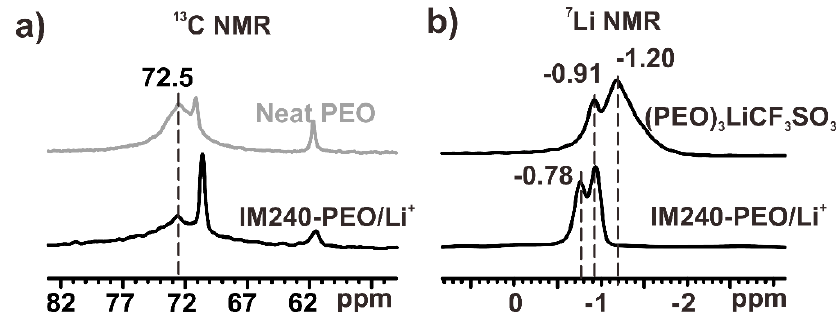
Figure 4. ( a ) The 13 C NMR spectra of neat PEO and IM240 ‐ PEO/Li + . ( b ) The 7 Li NMR spectra of (PEO) 3 LiCF 3 SO 3 and IM240 ‐ PEO/Li + . The temperature in the NMR experiments was 300 K.